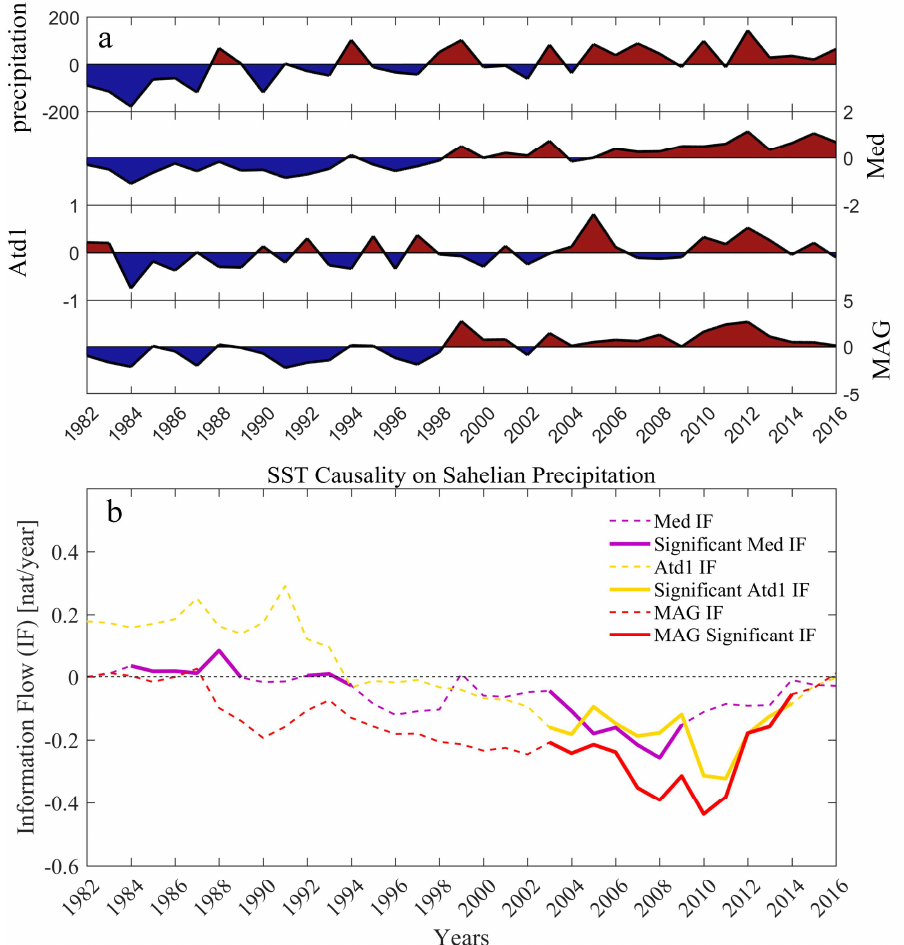
Figure 5. Anomalies and information flow. ( a ) Annual anomalies of M–O precipitation—Med, Atd1, and MAG between 1982 and 2016. ( b ) The information flow from three M–O SST indices—Med (purple), Atd1 (yellow), and MAG (red)—to the Sahelian precipitation from 1982 to 2016. Solid lines represent statistically significant values which imply causality. Missing values at the beginning are due to the Kalman filter computation, where earlier values are used to forecast latter values.